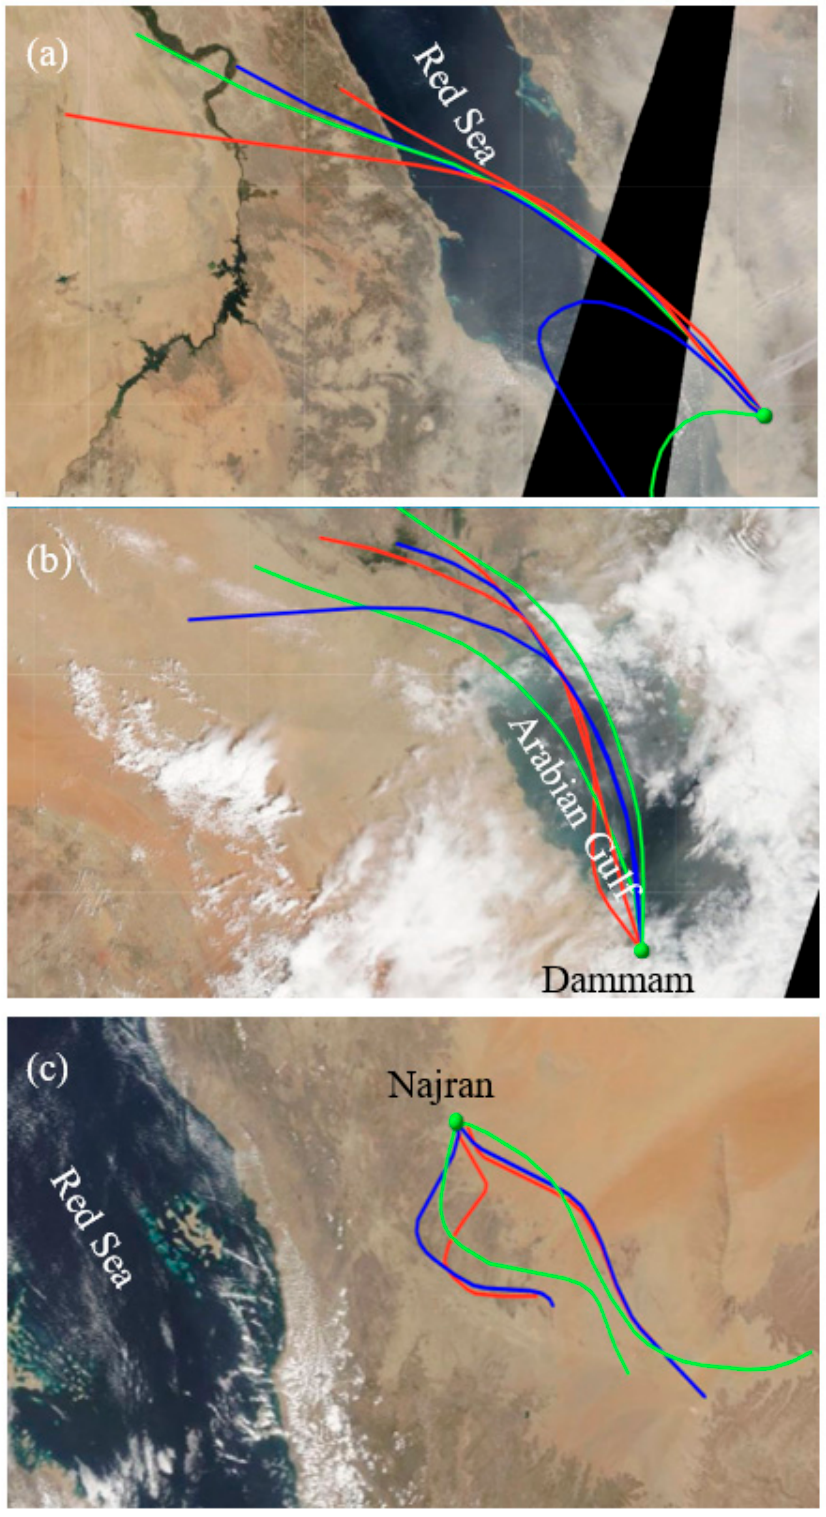
Figure 9. NOAA HYSPILT back trajectories modeling air mass on ( a ) 20 March 2017, ( b ) 23 April 2018, and ( c ) 15 April 2021.